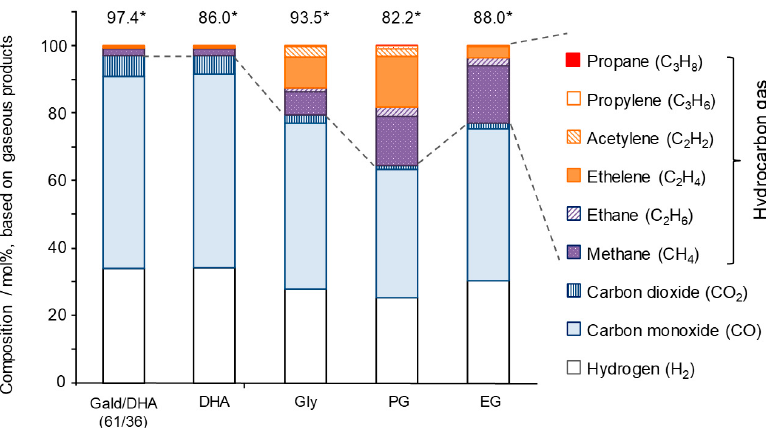
Figure 3. Composition (mol%) of non-condensable (gaseous) products from glyceraldehyde (Gald) / 1,3-dihydroxyacetone (DHA) (61 / 36, mol / mol), DHA, glycerol (Gly), propylene glycol (PG), and ethylene glycol (EG) at 800 ◦ C (residence time of 0.9 s under N 2 flow of 400 mL min − 1 ). * Yield (%, C-based) of the non-condensable product. The data of Gald / DHA, DHA and Gly are from literature